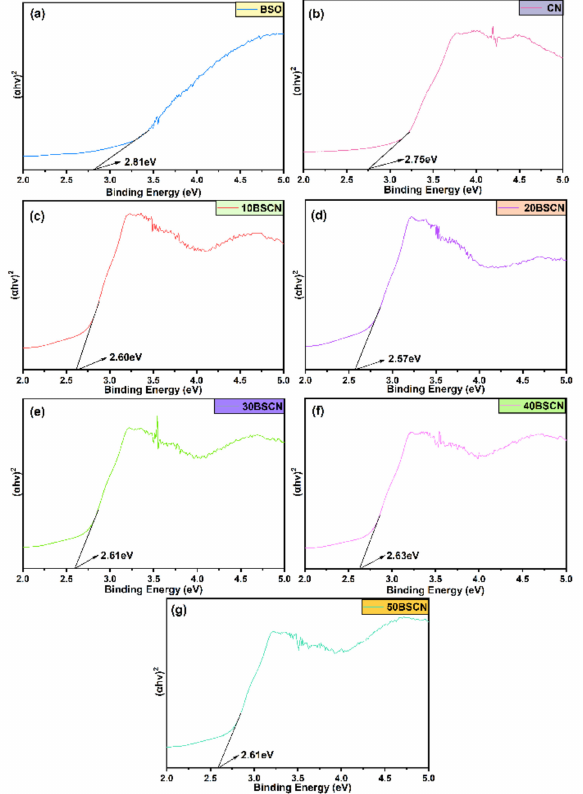
Figure 6. DRS analysis of BSO ( a ), CN ( b ), 10BSCN ( c ), 20BSCN ( d ), 30BSCN ( e ), 40BSCN ( f ), and 50BSCN ( g